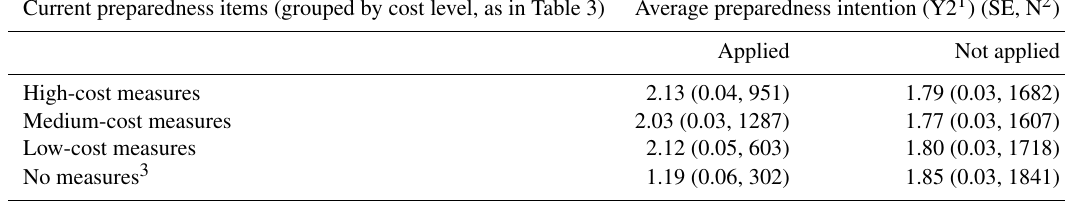
Table 8. Average preparedness intention between the respondents who applied and the ones who did not apply flood-precautionary measures. Current preparedness items (grouped by cost level, as in Table